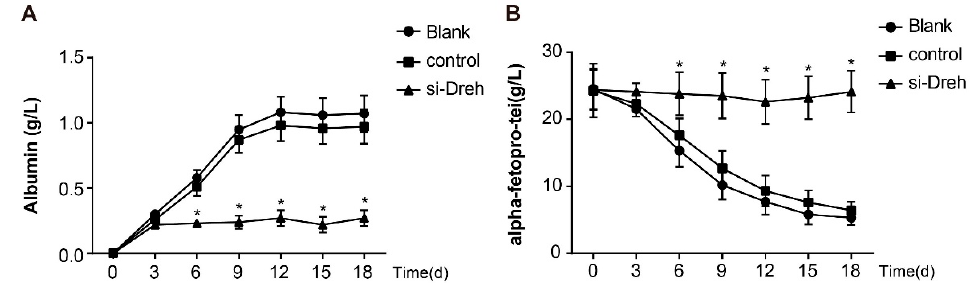
Figure 7. The synthesis ability of ALB and AFP during the differentiation of WB-F344 is changed after LncRNA-Dreh silencing. ( A ) synthesis ability of ALB is decreased during the differentiation of WB-F344 after LncRNA-Dreh silencing; ( B ) synthesis ability of AFP is increased during the differentiation of WB-F344 after LncRNA-Dreh silencing. * p < 0.05, vs. the blank and control groups at the 6th, 9th, 12th, 15th and 18th day. Cells without any transfection were used as the blank group, cells with blank plasmid transfection were used as the control group. The results are given as means